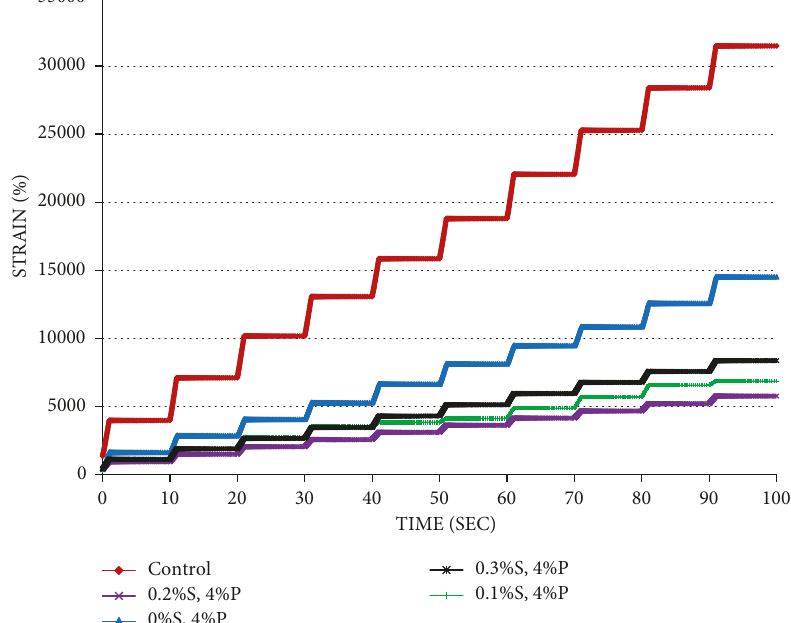
Figure 8: Accumulated stains of modified bitumen for different sulfur contents and 4% polymer content tested at 64 ° C.